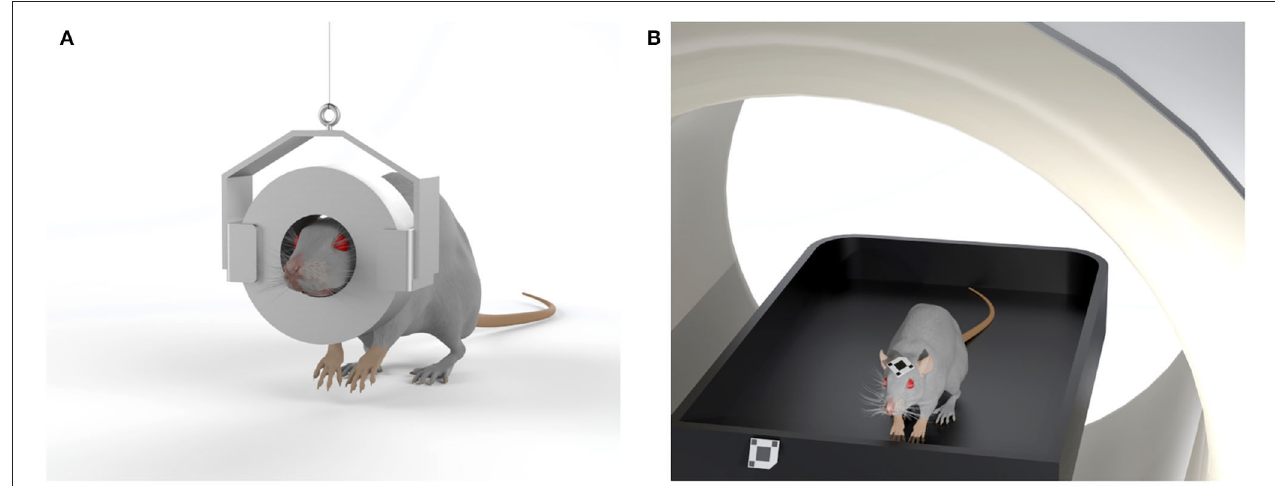
FIGURE 6 | Sketches of two systems designed to eliminate the need for anesthesia in rodent studies. (A) The RatCAP tomograph (rat conscious animal PET) consisting of a miniaturized full-ring PET scanner which is attached directly to the head, covering nearly the entire brain; (B) The open-field PET system, based on a commercial preclinical scanner, enables brain scans of rodents in motion due to an optical motion tracking and a custom designed motion-adaptive animal enclosure attached to a robotic